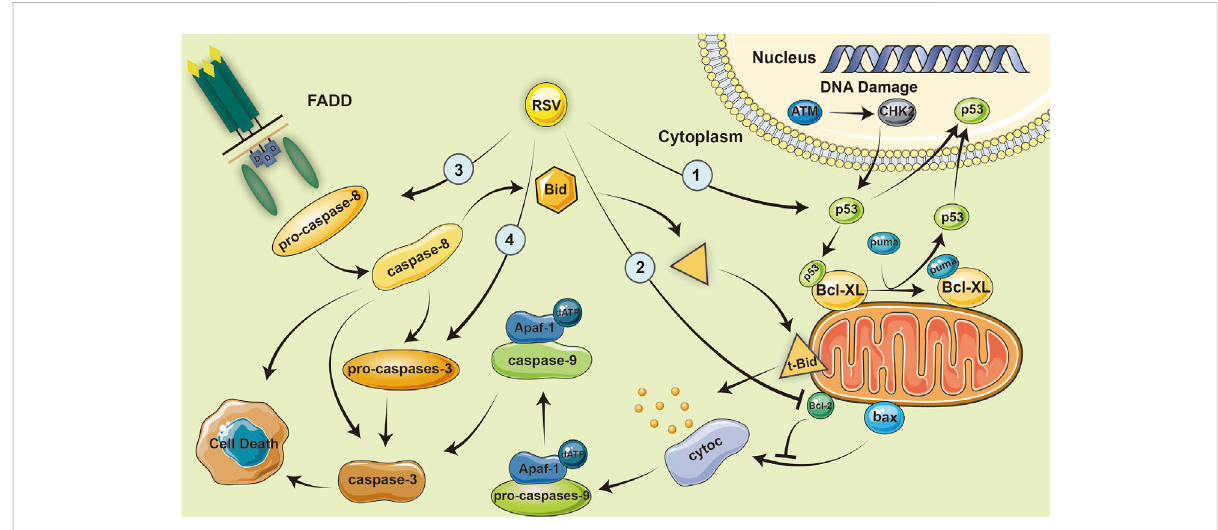
FIGURE 2 Resveratrol inhibits RA by promoting apoptosis. Resveratrol inhibits the expression of BCL-XL in MH7A cells, which enhances the activation of caspase-8 in fl s-85 cells and causes the ef fi cient release of cytoc in mitochondria, eventually activating caspase-9 and caspase-3, and promoting